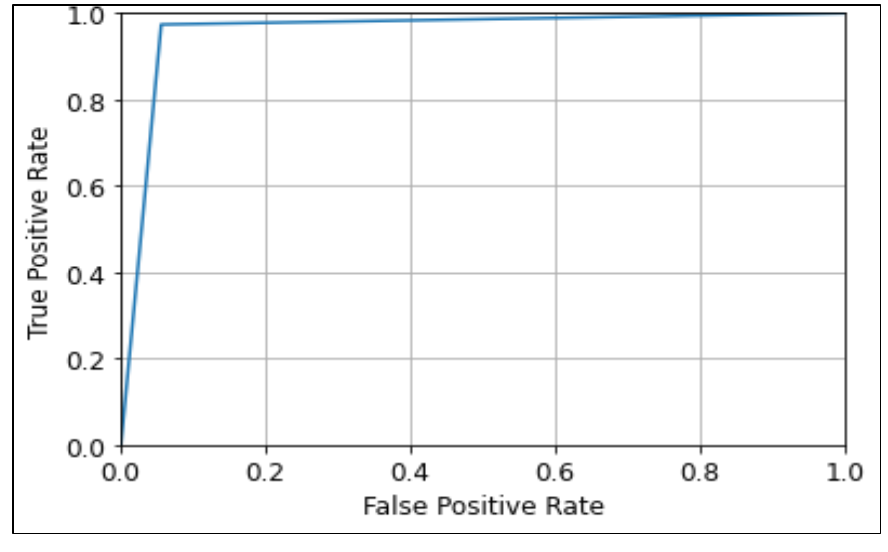
Figure 13. ROC Curve of CNN model.